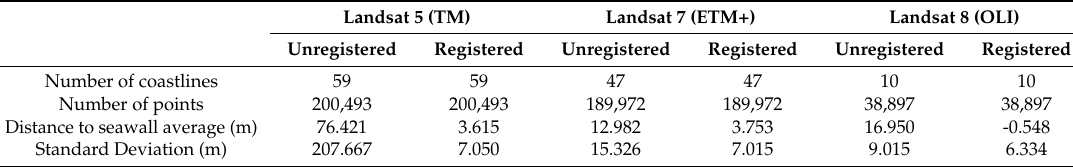
Table 2. Statistics derived from the evaluation of sub-pixel Landsat coastlines on stabilized by seawalls